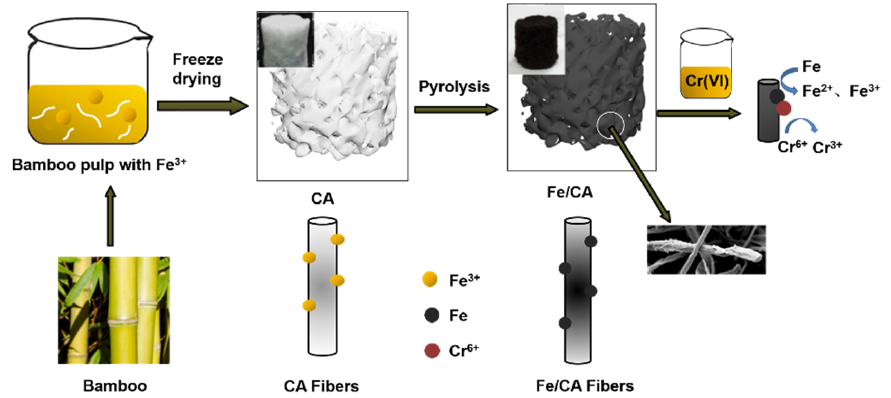
Figure 1. Schematic of the synthesis of Fe/CA.